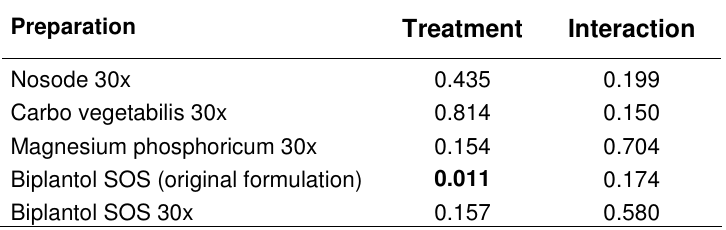
p Values of the Global F Test of ANOVA for the Main Experiments Assessing the Effects of a Homeopathic Treatment and the Interaction of Treatment and Date of the Experiment on the Infection Rate of A. thaliana